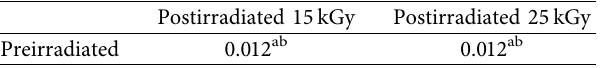
Table 3: Comparison of TGF- β levels in the freeze-dried amnion membrane (FD-AM) before and after radiation